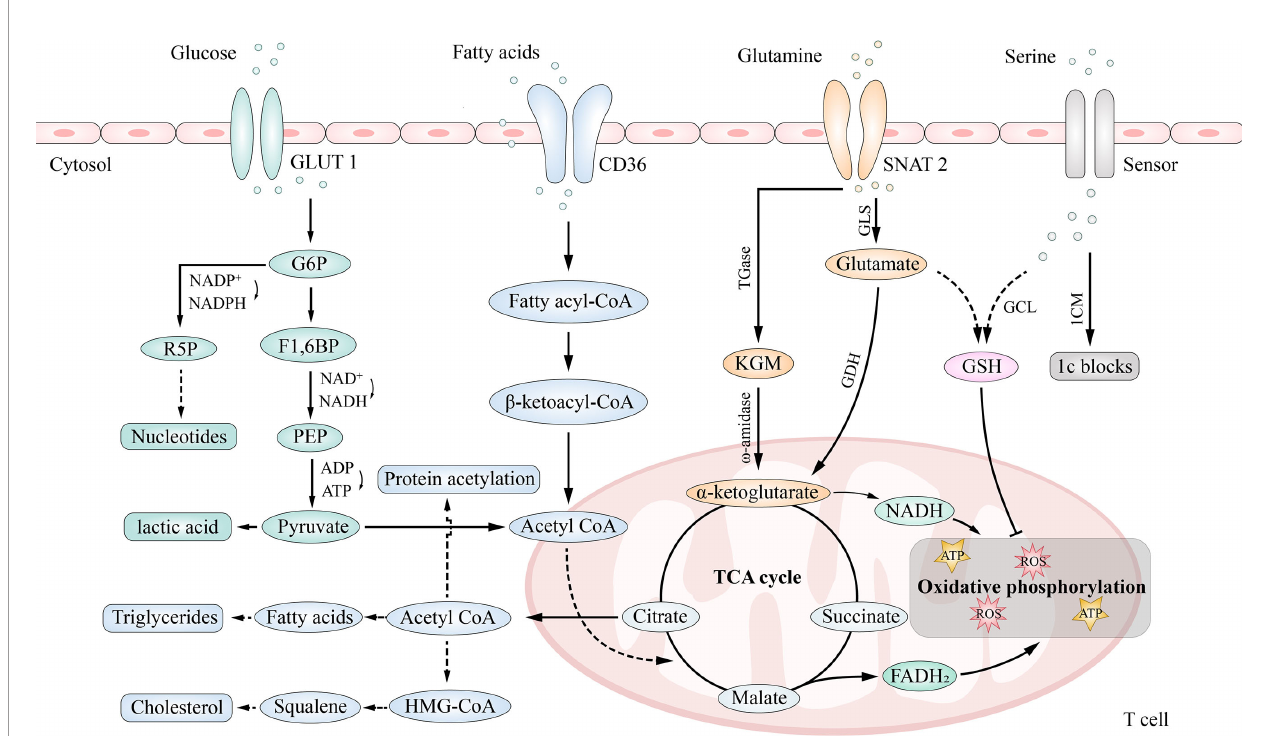
FIGURE 3 | Main metabolic pathways in T cells. T cells generate ATP by glycolysis and oxidative phosphorylation. Pentose phosphate pathway (PPP) is a branch of glycolysis pathway. Cells also generate energy by using glutamine (Gln), which is metabolized by glutaminolysis, and lipids( b -oxidation). Additionally, Serine enters the cell from the extracellular space and then, either enters one-carbon metabolism (1CM), which generating one-carbon (1C) building blocks for anabolism, or produces the ROS scavenger glutathione